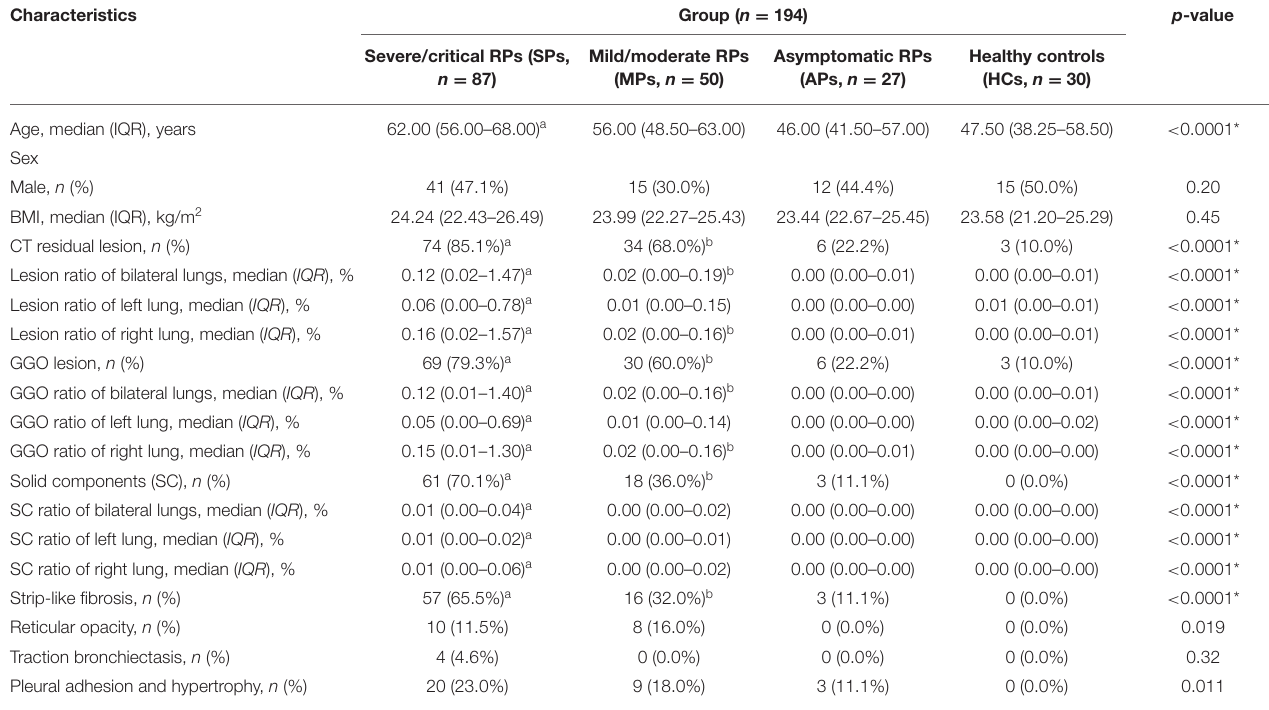
TABLE 2 | Artificial intelligence (AI) assisted manual identification of CT features in patients recovered from COVID-19 at 3 months post-discharge.